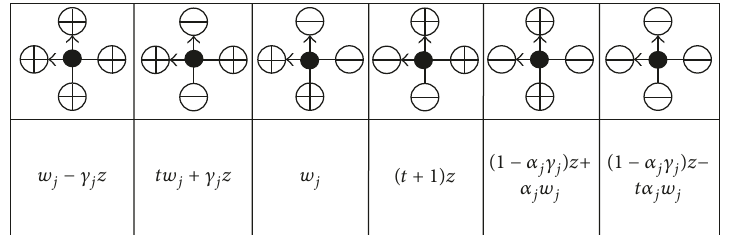
Figure 1: The 𝐿 -operator 𝐿 𝑎𝑗 (𝑧, 𝑤 𝑗 , 𝛼 𝑗 ,𝛾 𝑗 ) (2). The horizontal line is the space 𝑊 𝑎 , and the vertical line is the space F 𝑗 .